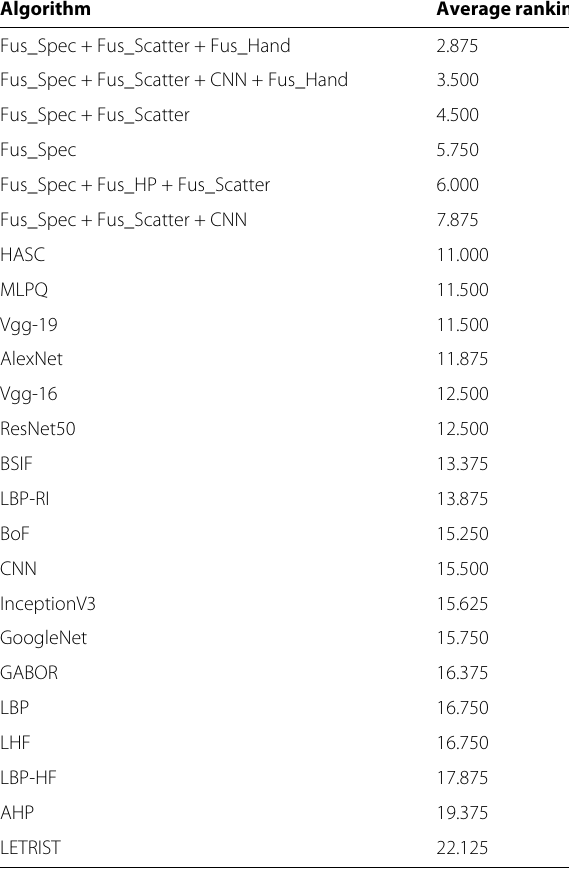
Table 4 Ordered rankings of the approaches